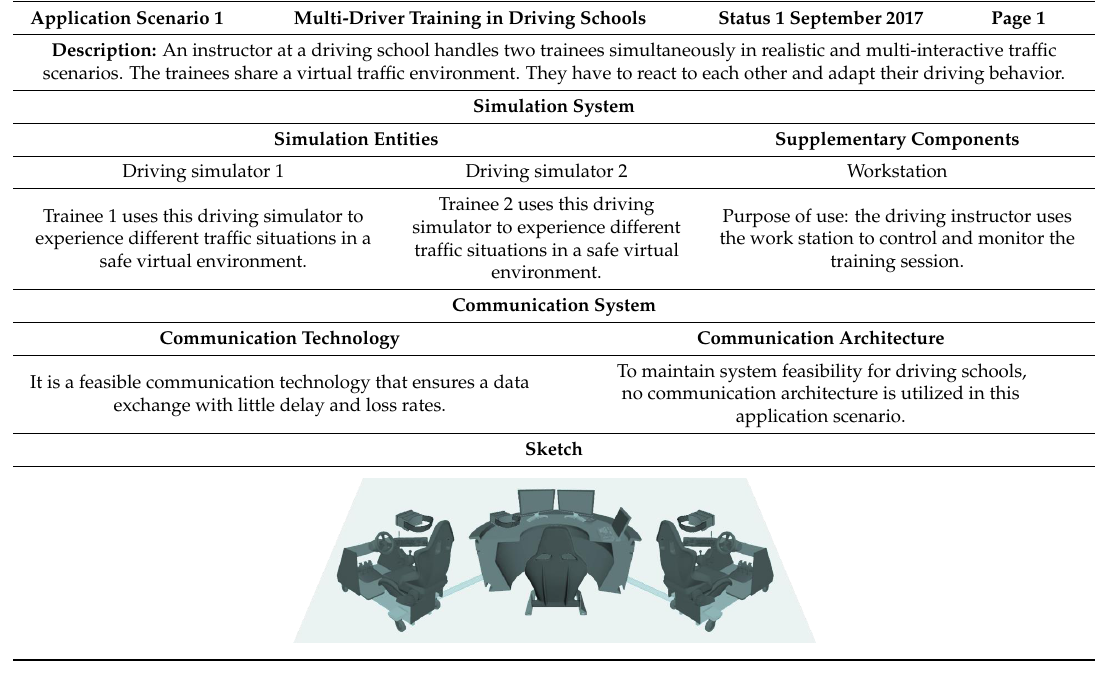
Table 6. Example application scenario of a networked driving simulation system.